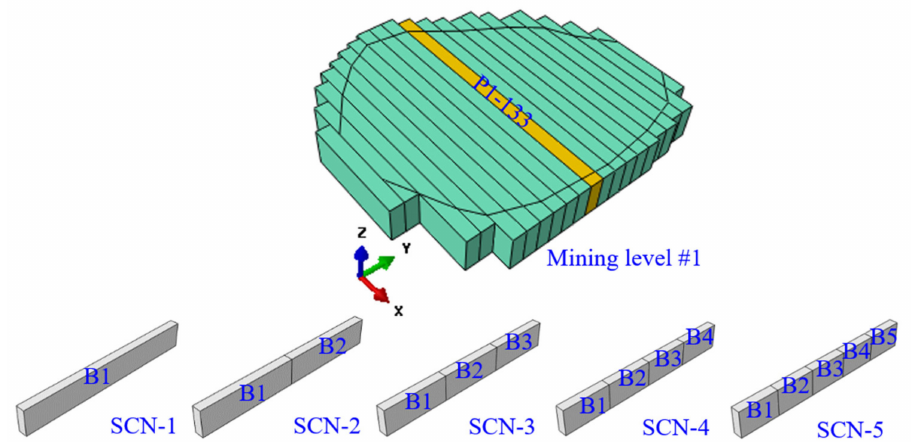
Figure 2. Profile of stope P1–133 and five backfilling step